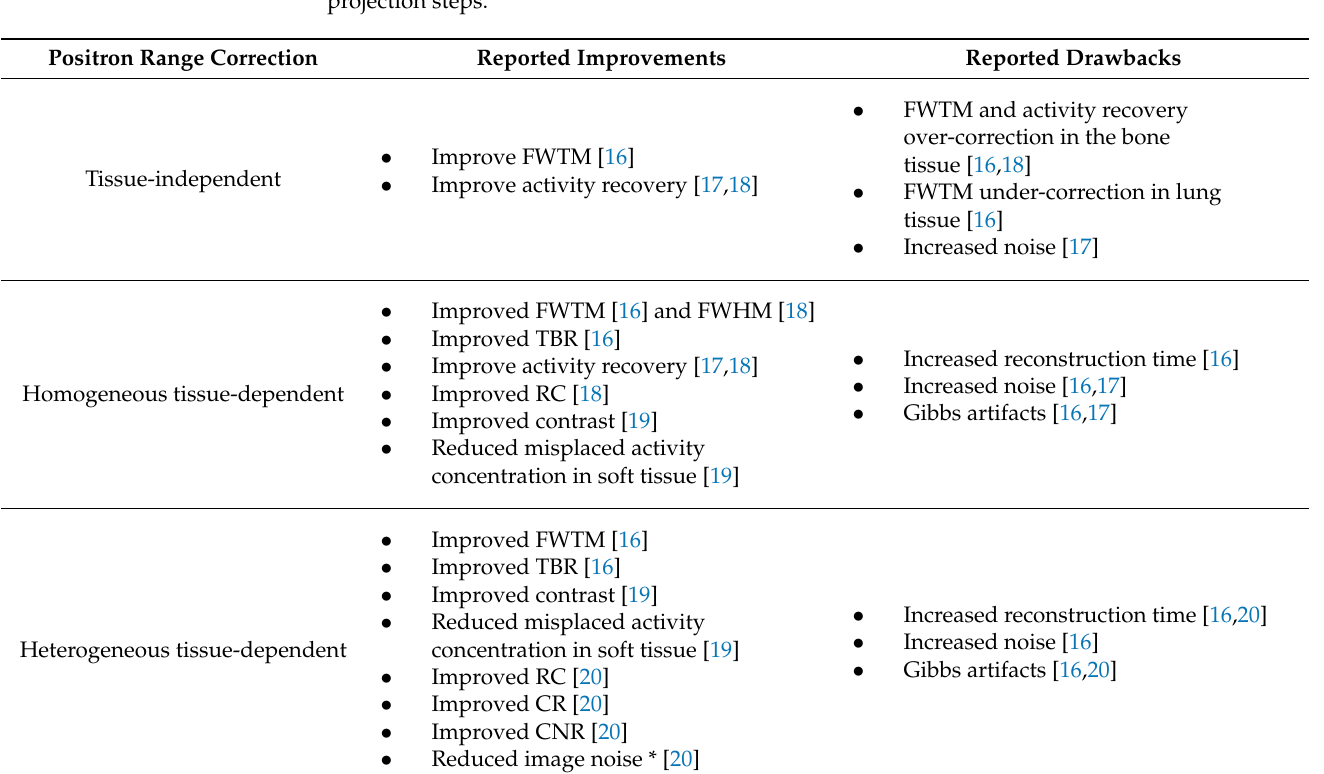
Table 2. Summary of the reconstruction-based corrections for 68 Ga. The asterisk (*) depicts an improvement observed by incorporating the blurring kernel both in forward and backward projection